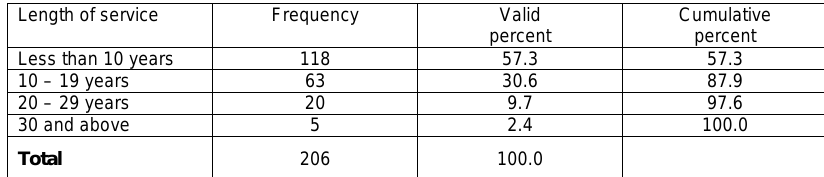
Table 3: Analysis of maintenance staff length of service in public hospitals